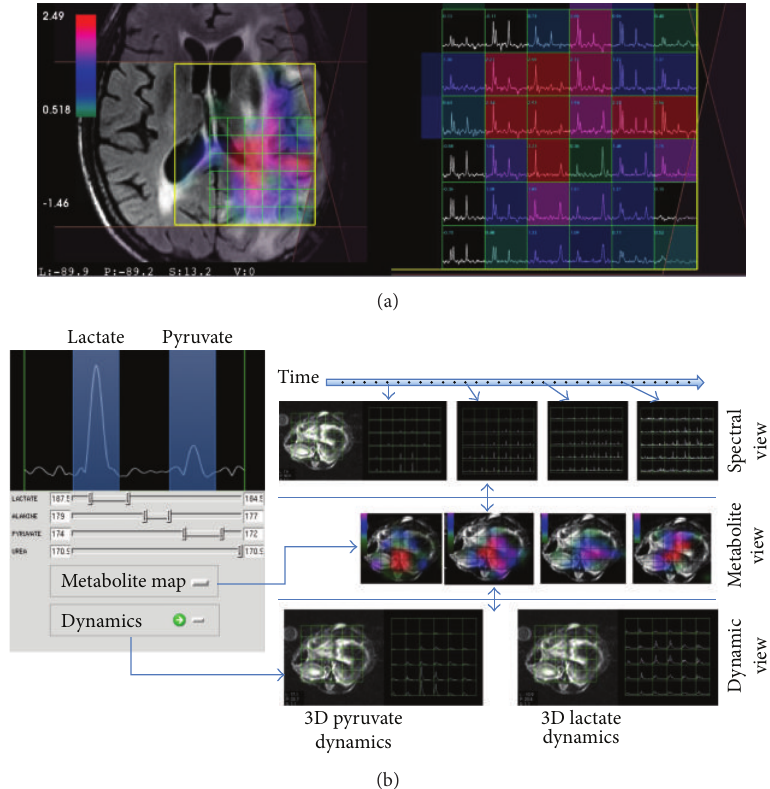
Figure 1: Multidimensional MRSI data visualization. (a) 4D brain MRSI data in SIVIC. Spectra from individual voxels are shown on the right. The left panel shows the spatial localization of each MRSI voxel on a reference anatomical image. The color overlay is a 3D metabolite map derived from spectral quantification of individual peaks. (b) 5D dynamic MRSI data. Metabolite peaks are derived from each point in a time series of 4D MRSI volumes. 3D dynamics of individual metabolites are represented by time curves in the bottom row for two different metabolites. The example at the bottom is from hyperpolarized 13 C MRSI of a rat.